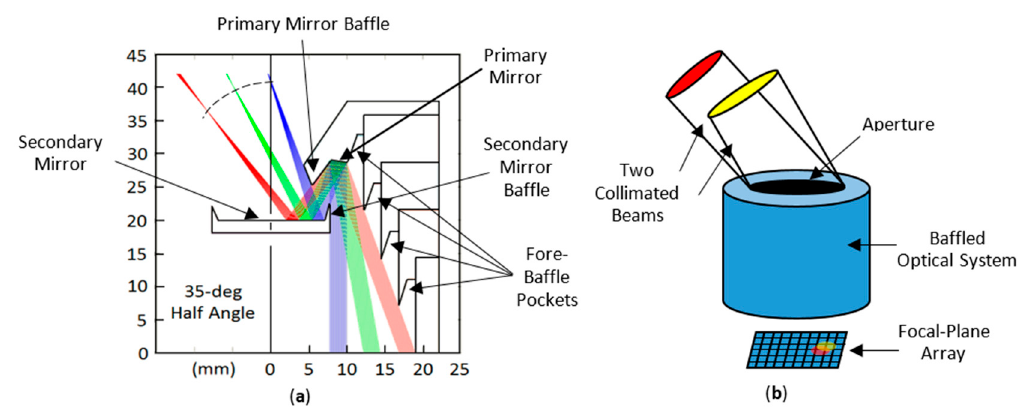
Figure 1. ( a ) DEMETER WFOV telescope concept, and ( b ) a generic optical instrument accepting two collimated